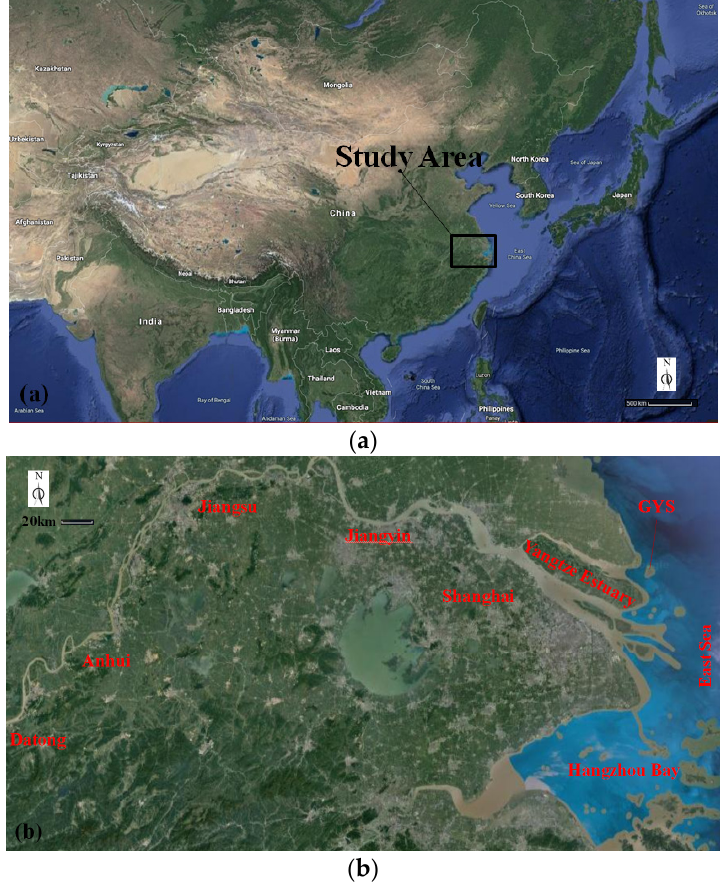
Figure 1. The location of the Yangtze Estuary and the study area (a Google Map diagram showing the geographical features of the location). ( a ) Location; ( b ) Tidal reaches and estuary.